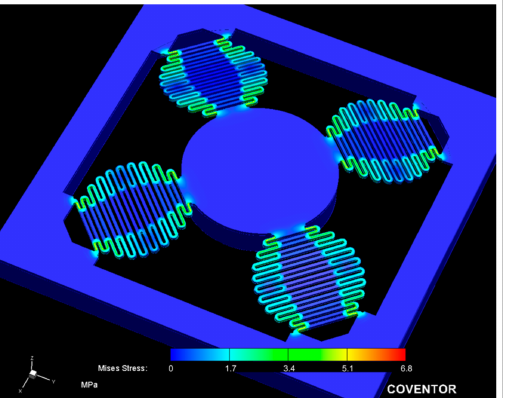
Figure 8. Stress-induced FEA simulation after applying force to the bottom of the proof mass.